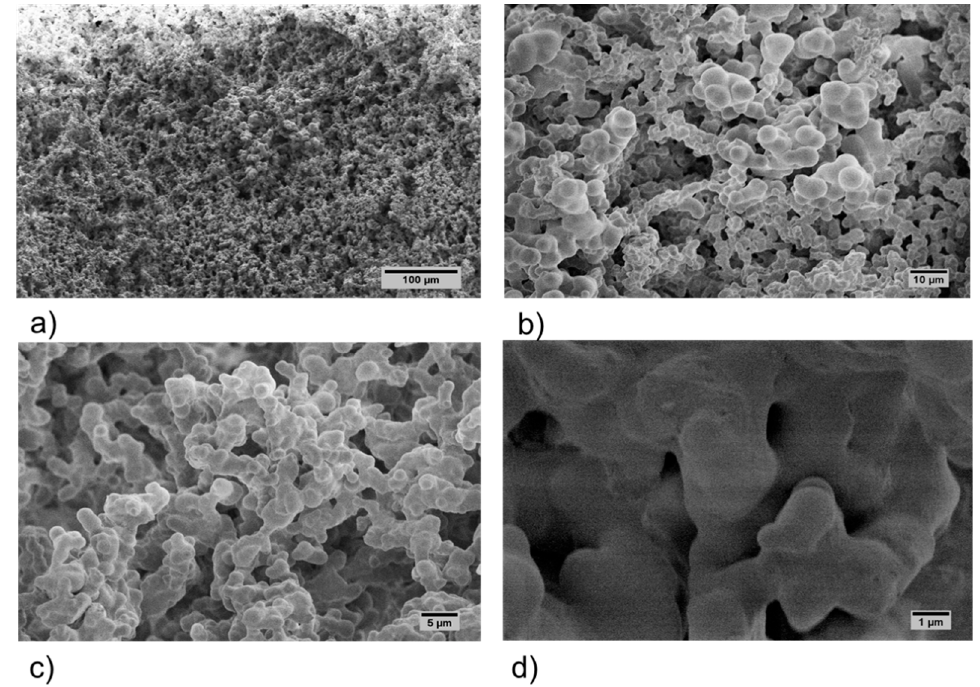
Figure 4. SEM micrographs of M2 acemannan aerogels at 200 × ( a ), 1000 × ( b ), 2000 × ( c ) and 10,000 × ( d ) magnification.